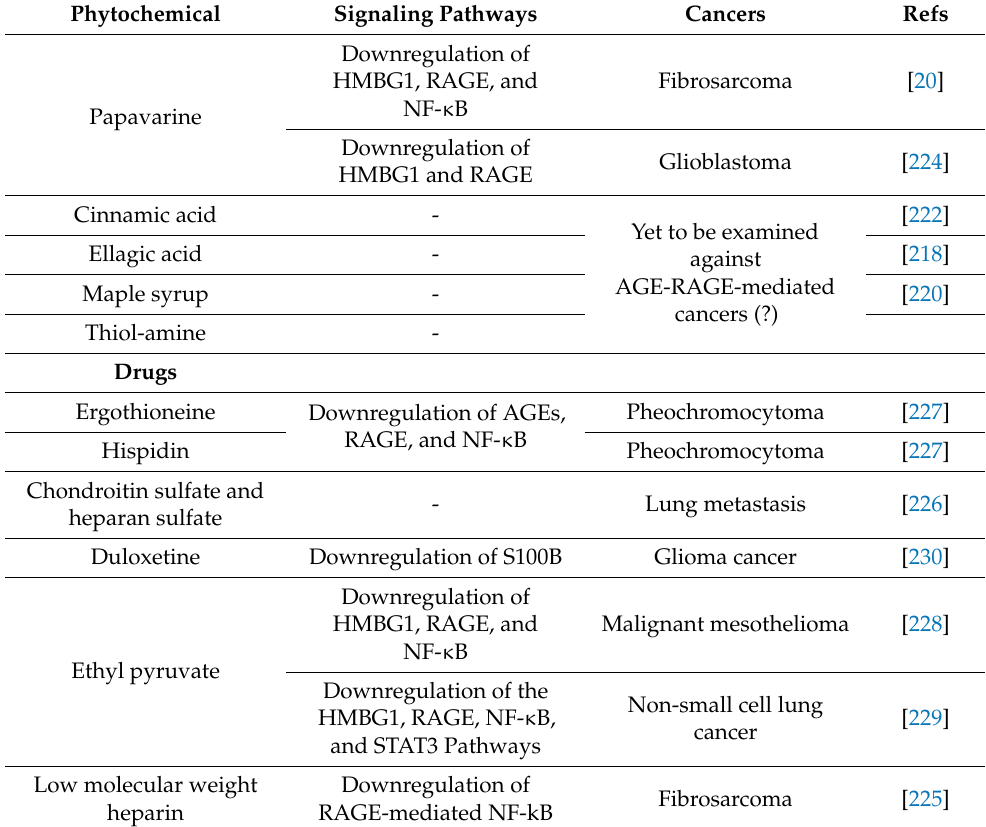
Table 2. Phytochemicals and drug interventions that modulate AGE-RAGE-mediated glycation to mitigate cancer cell